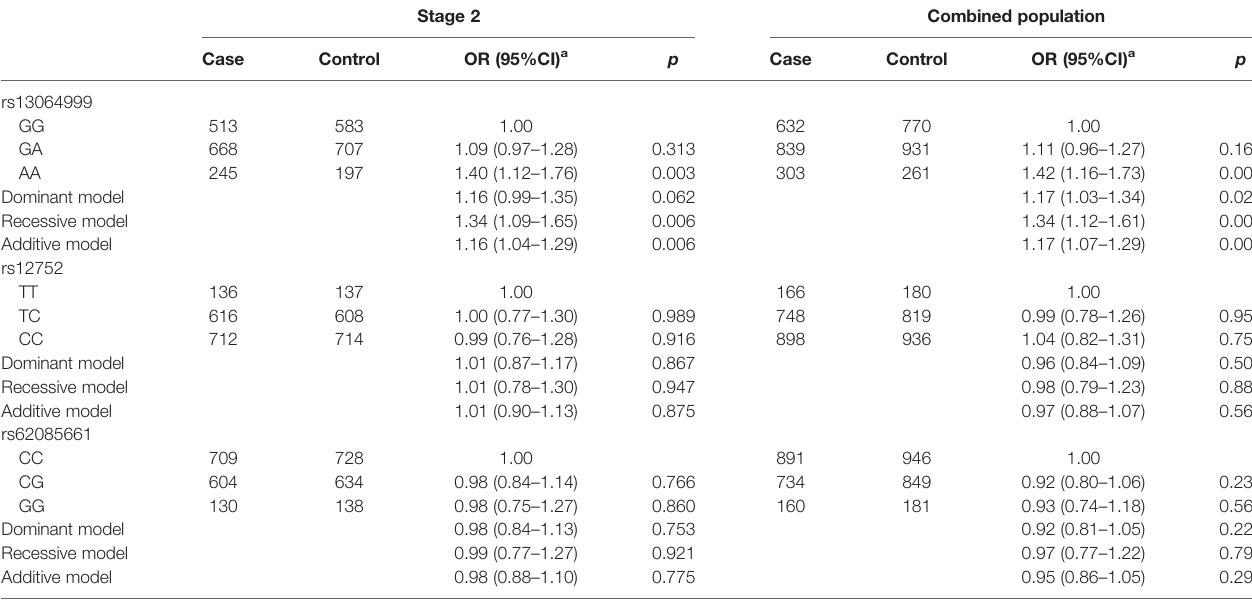
TABLE 3 | Association analyses between three SNPs and NSCLC risk in stage 2 and combined